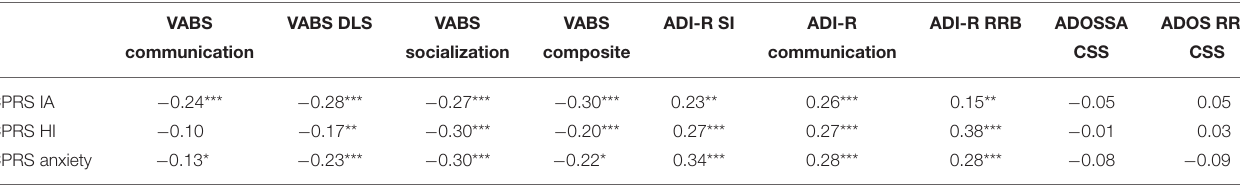
TABLE 5 | Correlations of CPRS subdomains scores with VABS, ADI–R, and ADOS subdomain